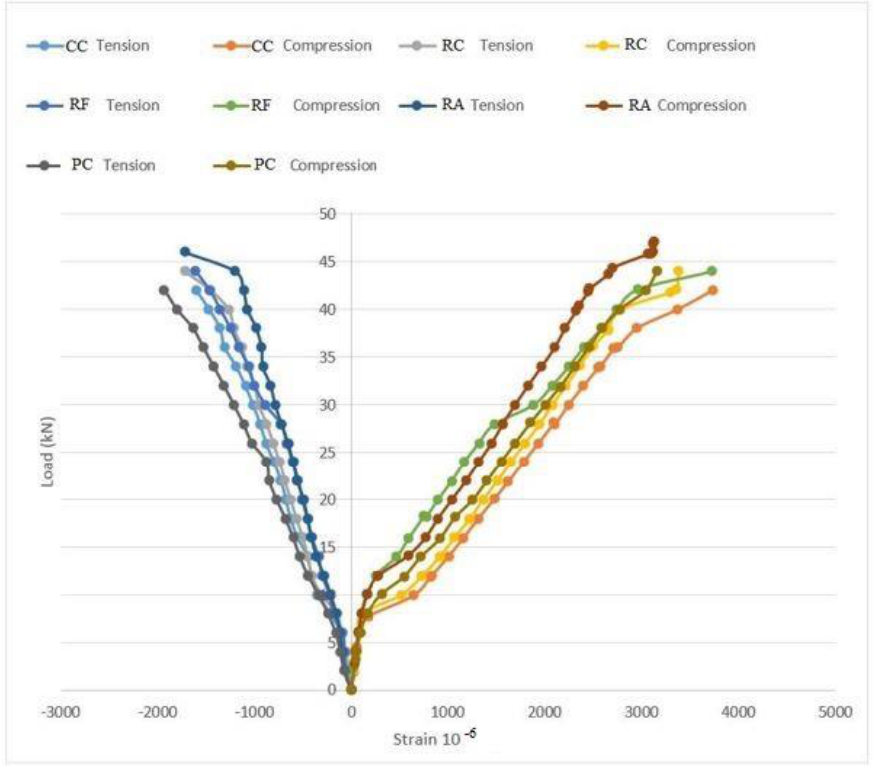
Figure 9. Load against mid-span strain of the beams.